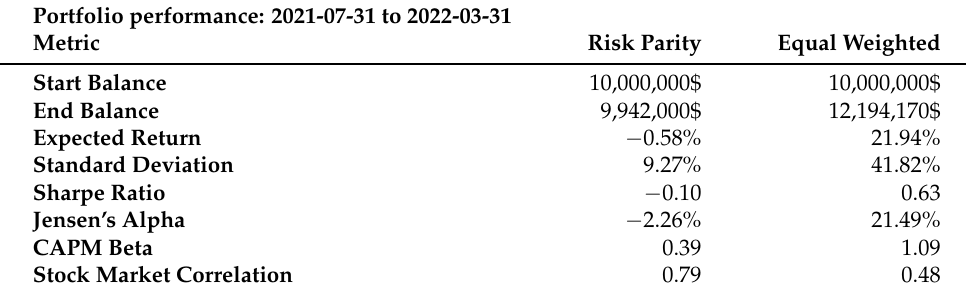
Table 7. Risk Parity versus Equal Weighting Results during Covid Phase